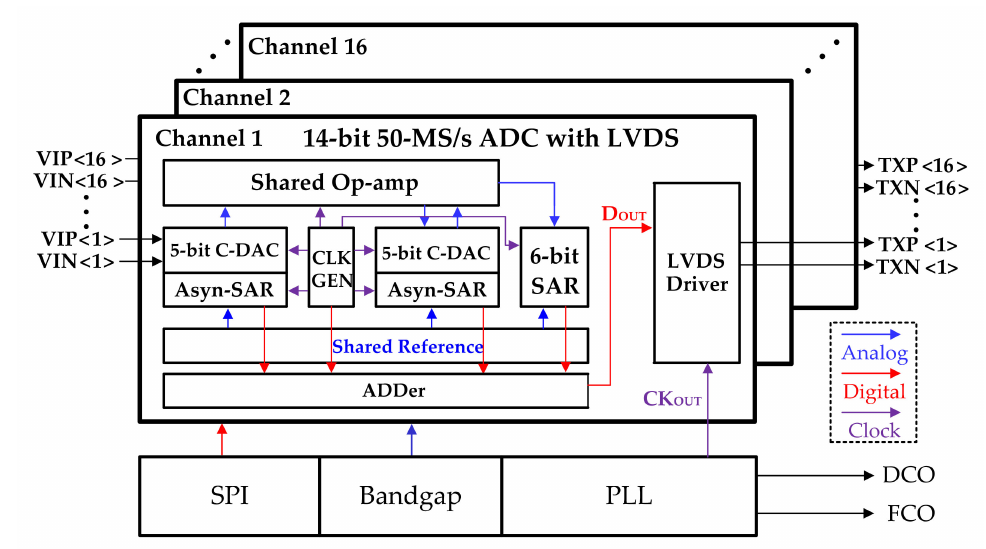
Figure 8. The overall structure of the proposed ADC. The ADC has 16 channels and each channel is drawn in the solid line box, including three sub-stages, the shared reference/op-amp and LVDS. The peripheral circuits shared by all channels are drawn below. As illustrated right, different signal flows are marked with arrows with different colors.